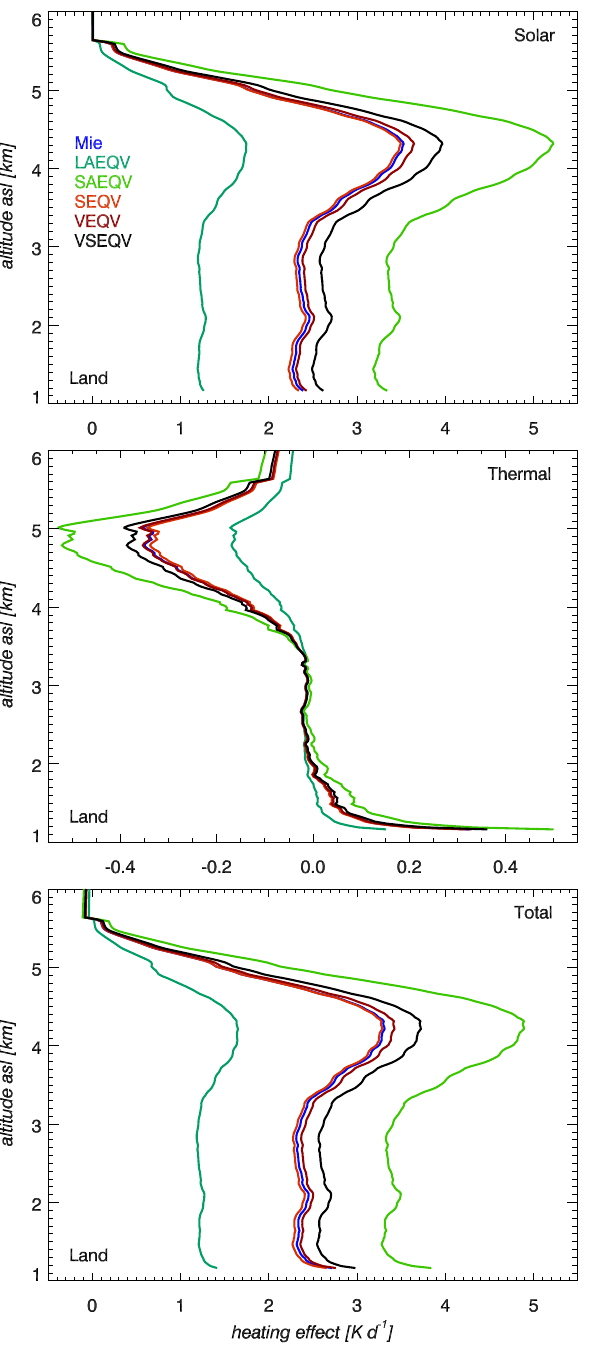
Fig. 18. Simulated heating effects 1H(z) by Eq. (4) of the Saharan mineral dust plume, observed on 19 May 2006 over OZT site about noon, over a mean land surface assuming spherical (Mie) and pro- late spheroidal model particles for various cases of size equivalence (LAEQV, SAEQV, SEQV, VEQV and VSEQV), representative for solar (top), thermal (centre) and total (bottom) spectral range.